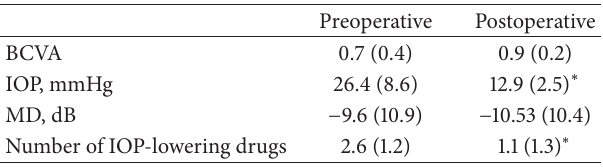
Table 1: Comparison between preoperative and postoperative parameters.